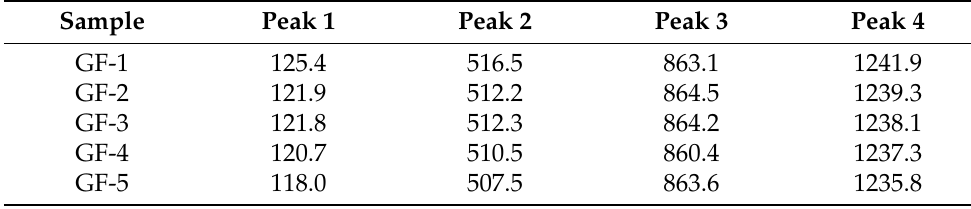
Table 5. Key temperature point of exothermic or endothermic peaks in DTA curves ( ◦